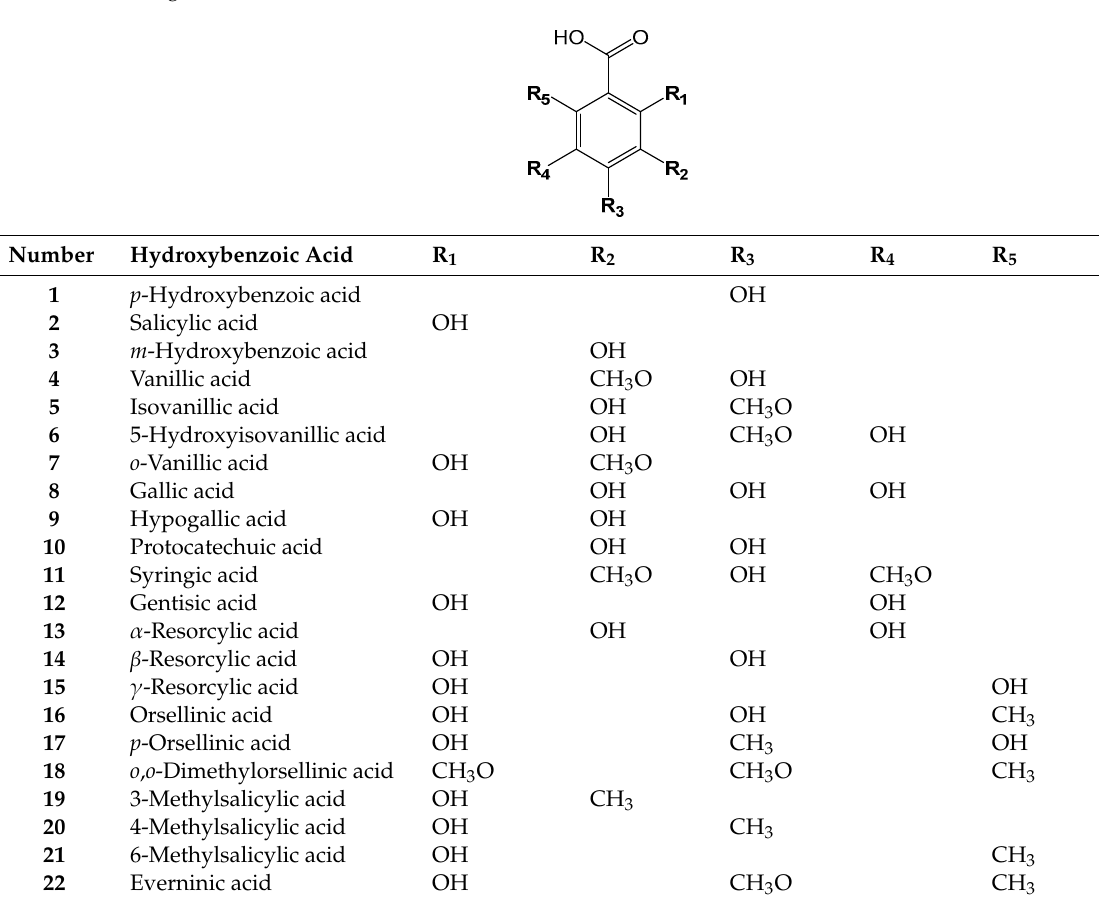
Table 1. The structure of hydroxybenzoic acids. The table represents the functional groups of aromatic ring.